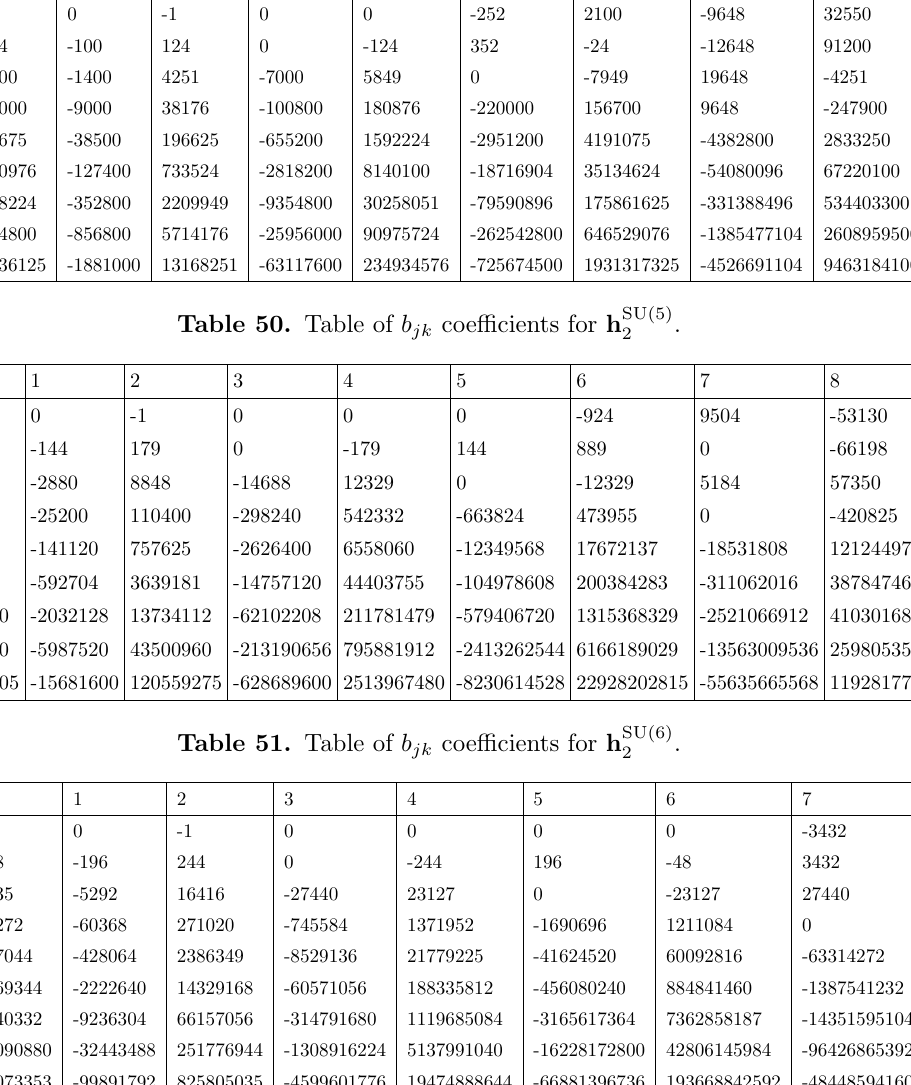
Table 52. Table of b jk coe(cid:14)cients for h SU(7)